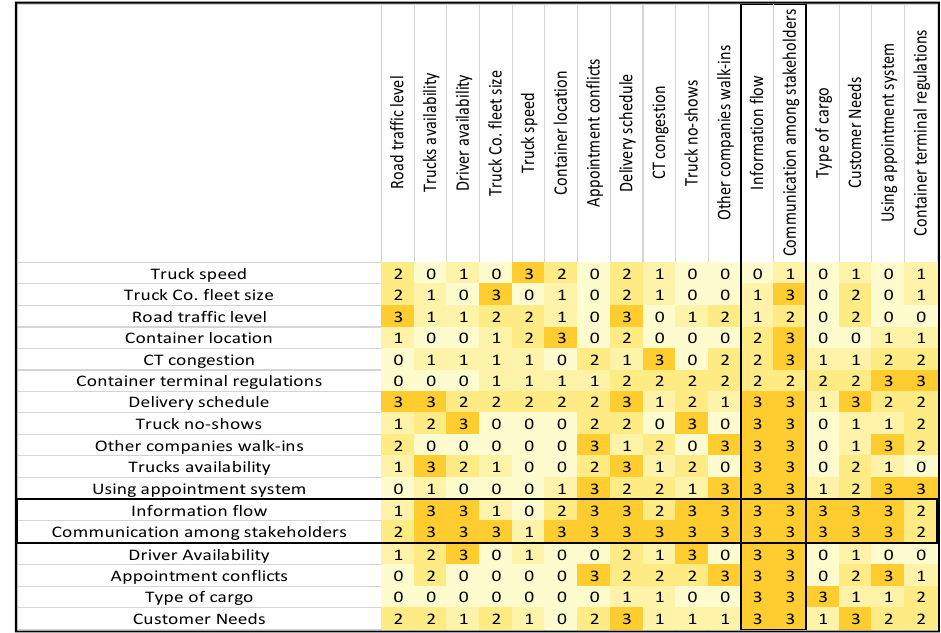
Figure 4. Insight matrix after sorting to generate patterns (clusters) of factors.